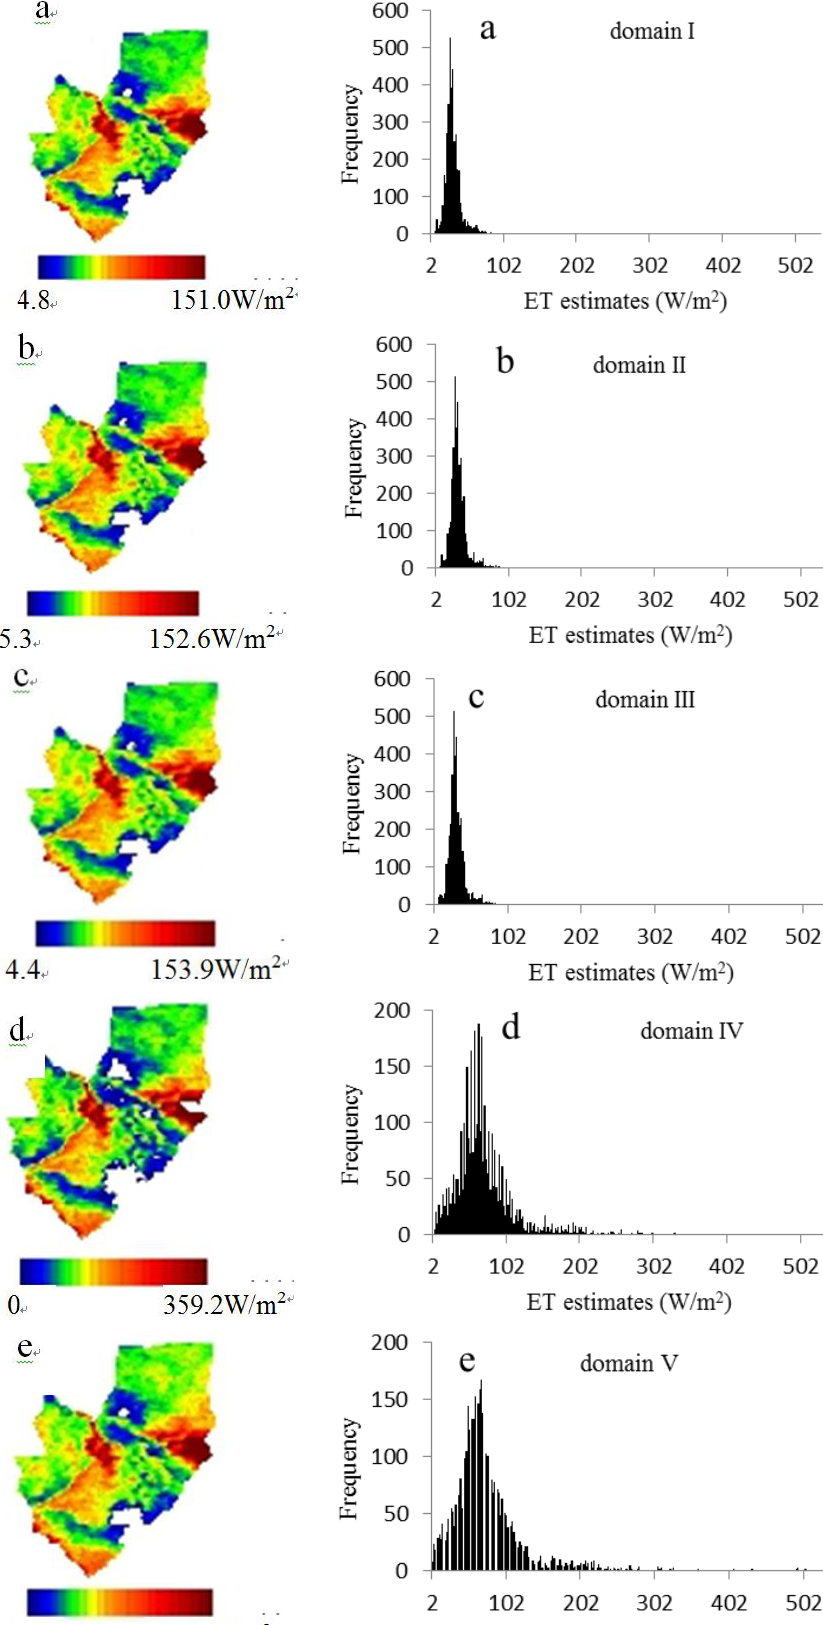
Figure 6. Distribution maps of ET estimates of domain V calculated from images covering domain I, II, III, IV and V on DOY